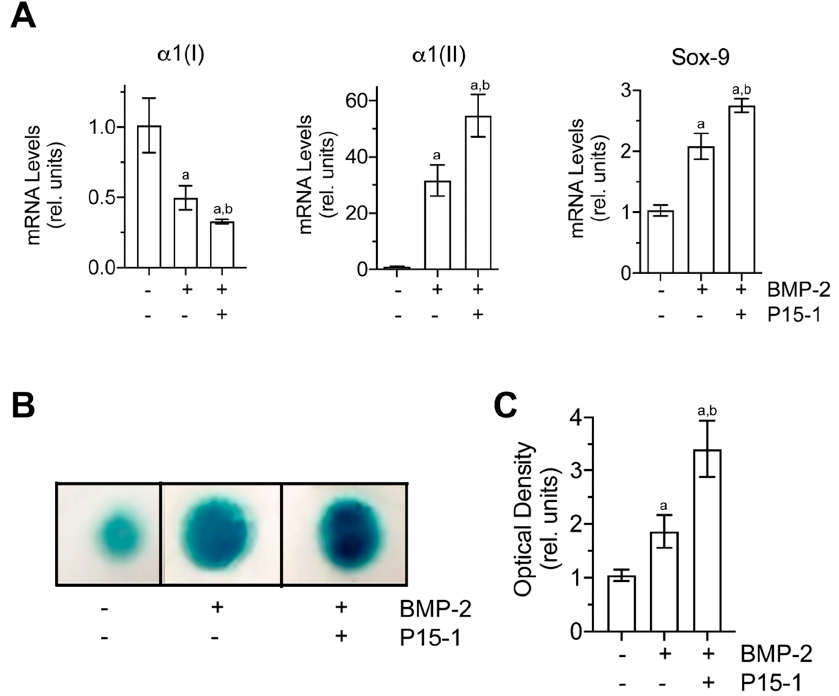
Figure 7. ( A ) mRNA levels of type I collagen ( α 1(I)), type II collagen ( α 1(II)), and Sox–9 in C3H10T1/2 micromasses cultured in the absence or presence of BMP–2 and P15–1. C3H10T1/2 cells were cultured in micronasses in the absence or presence of BMP–2 and P15–1 for 3 days. The mRNA levels of type I collagen ( α 1(I)), type II collagen ( α 1(II)), and Sox–9 were determined by real-time PCR using SYBR Green and normalized to the level of 18S RNA. Data were obtained from triplicate PCRs using RNA from 3 different cultures. Data are expressed as relative units with the mRNA levels of the vehicle–treated cells set as 1. Values are the mean ± SD. ( B ) Alcian blue staining of C3H10T1/2 micromasses cultured in the absence or presence of BMP–2 and P15–1 for 3 days. ( C ) Optical density of the stained Alcian blue micromases analyzed by ImageJ. Data are expressed as relative units with the values of vehicle–treated micromasses set as 1. a p < 0.01 vs. vehicle-treated cells; b p < 0.01 vs. BMP-2–treated cells.